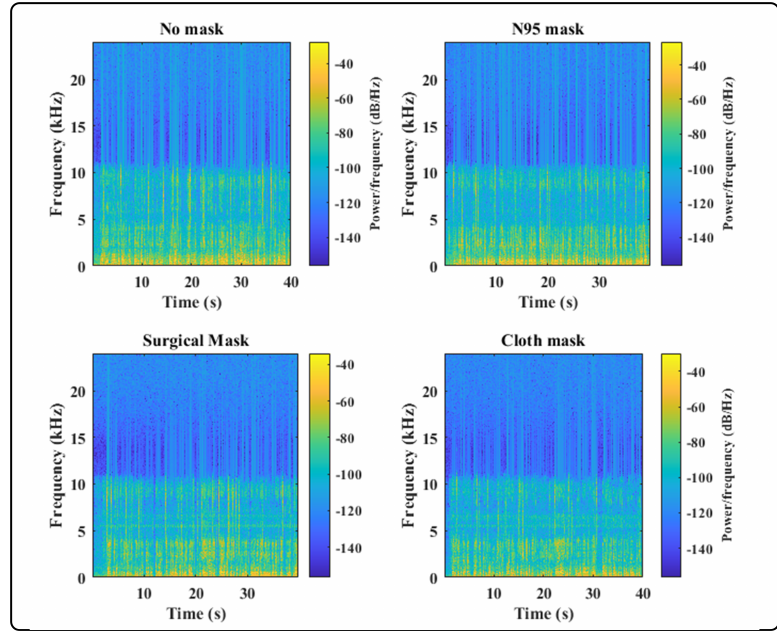
Figure 1. Spectrogram analysis of speech samples with and without a face